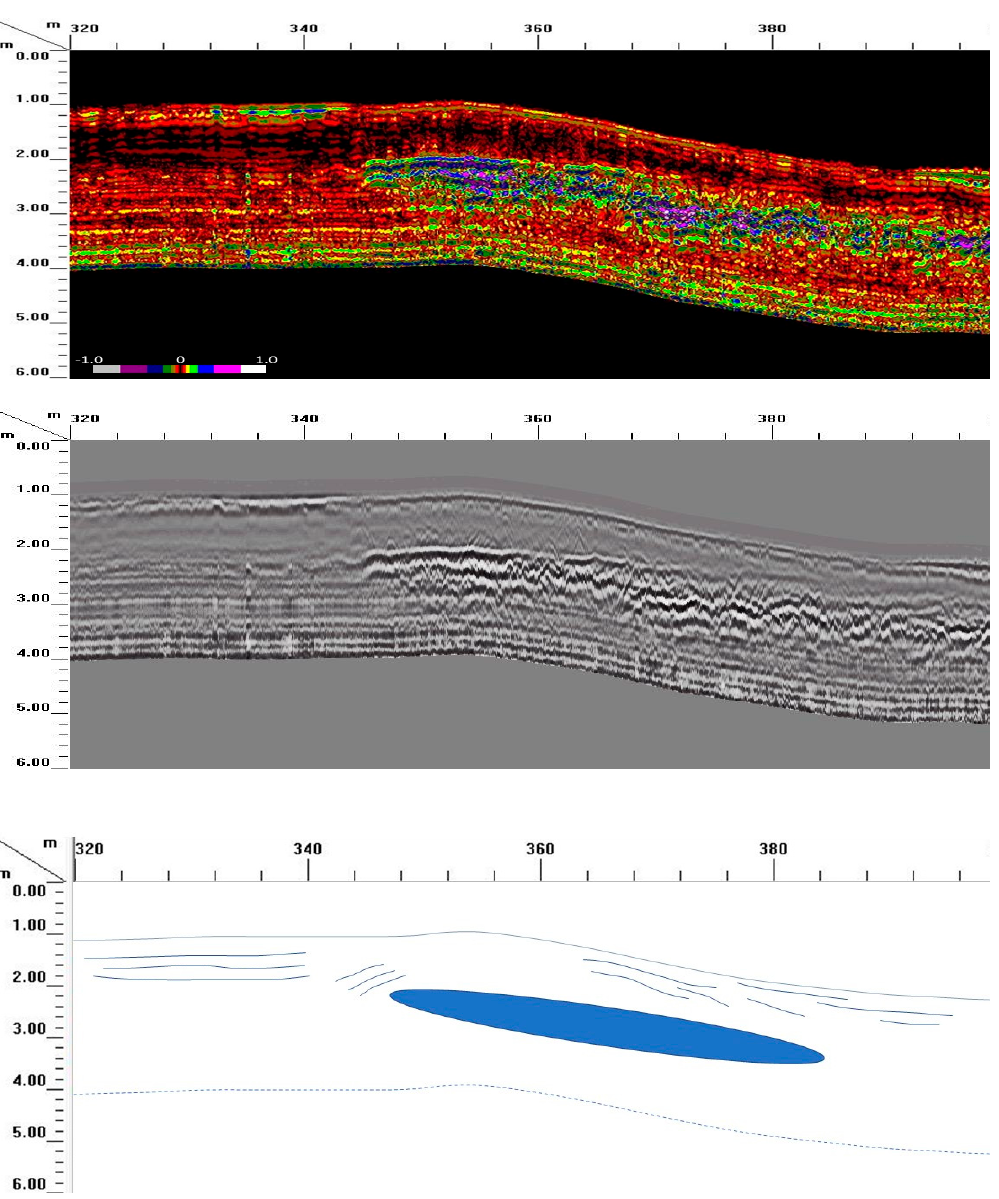
Figure 15. GPR profile and interpretation for the 1712 m shoreline. In the upper transect, data are presented with a color scale to highlight the normalized intensity of radar reflectors. The lower profile presents the same data in grayscale. In both profiles, landward is to the left and lakeward is to the right. The blue oval designates the zone of high-amplitude reflectors seen beneath the crest and lakeward slope of the beach ridge. Vertical exaggeration 5×.